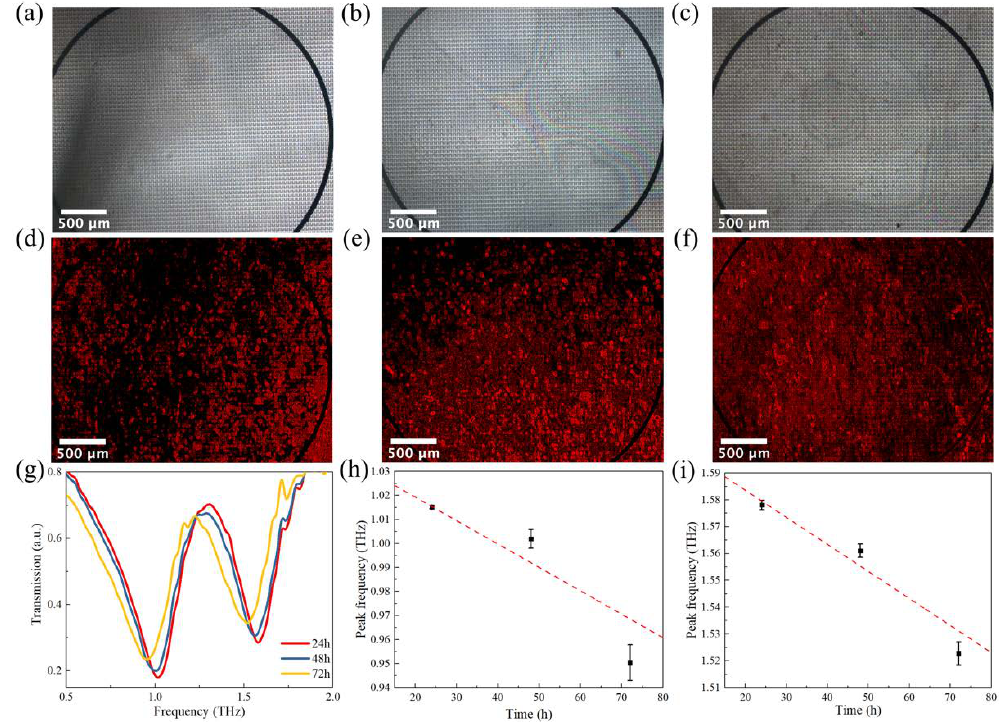
Figure 5. Experiment results of cells growing on the biosensor. ( a – c ) Micrograph of the biosensor with cells growing after 24 h, 48 h, and 72 h; ( d – f ) fluorescence pictures corresponding; ( g ) the transmission spectra of the biosensor with cells growing after 24 h, 48 h, and 72 h; ( h ) the dependence of peak 2 shift extracted from ( g ) on growth time. ( i ) The dependence of peak 1 shift extracted from ( g ) on growth time.